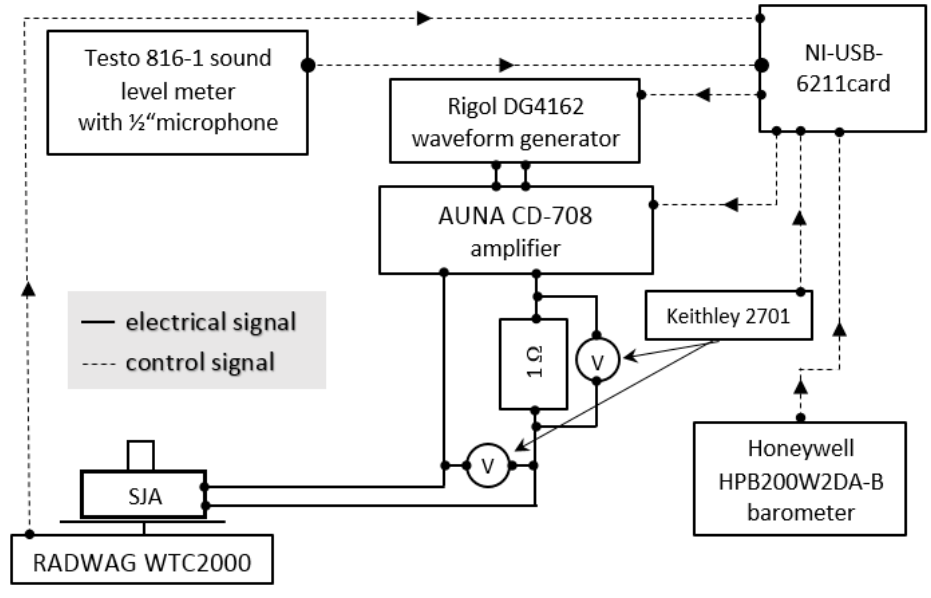
Figure 3. Measurements stand.